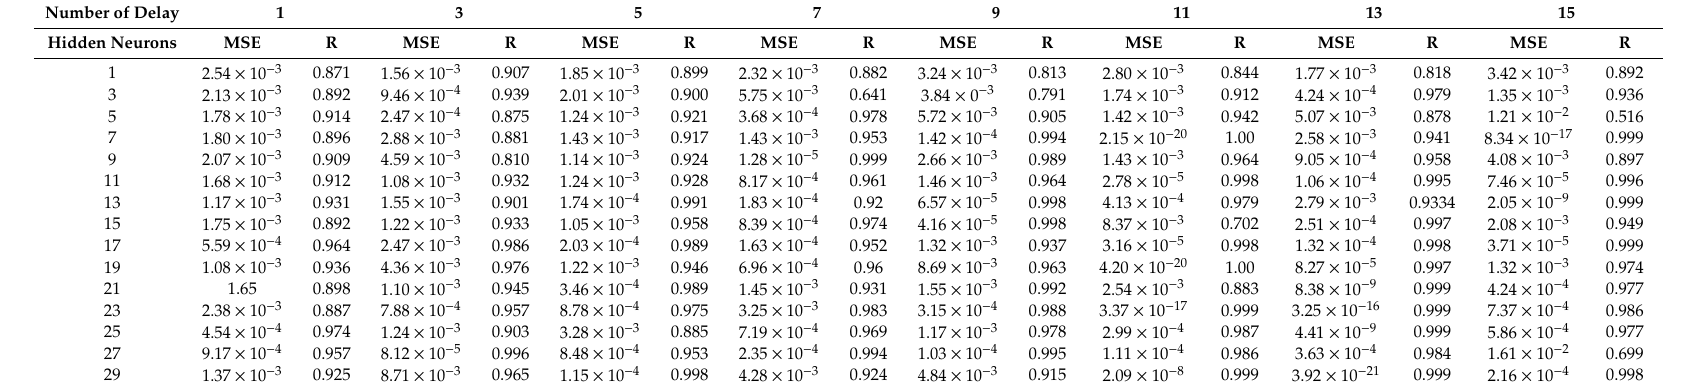
Table A1. Detail results of the optimization of the hidden neurons at varying delay using training data for Malaysia.